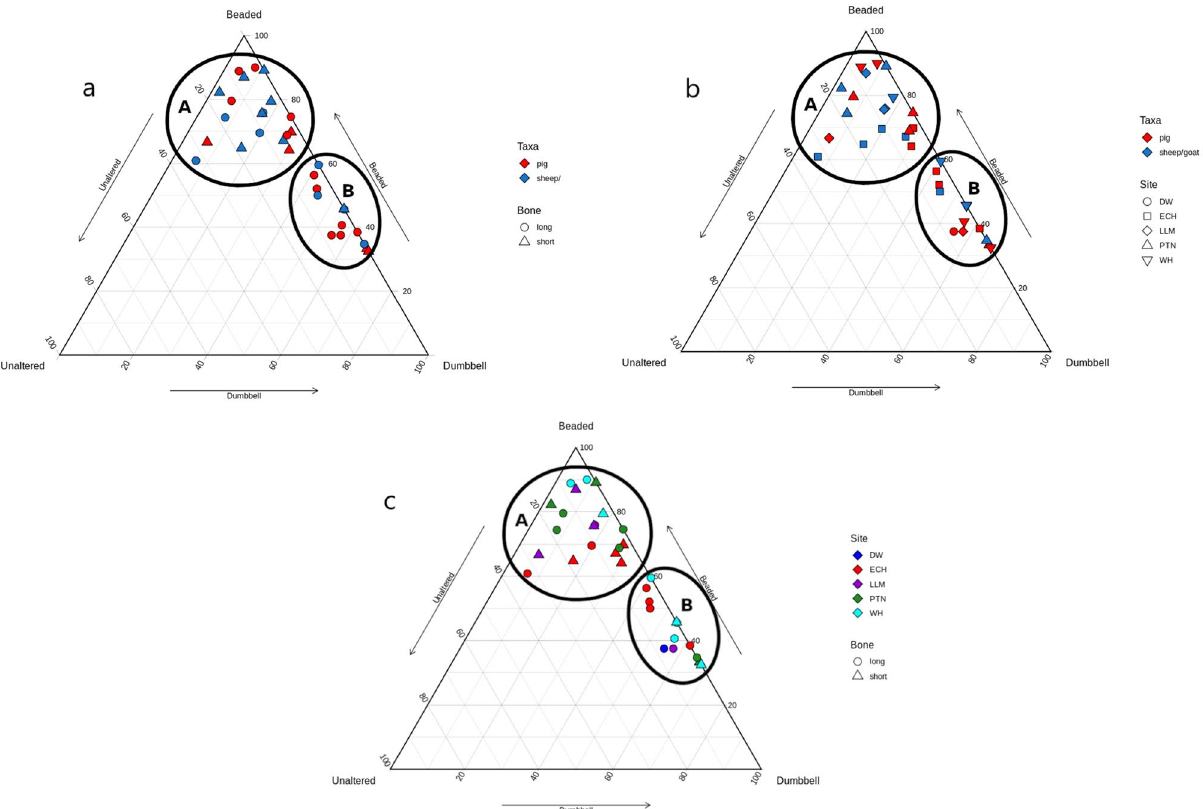
Figure 8. Ternary plot of all analysed samples. ( a ) presents the samples by element and species, ( b ) presents the samples by species and site, and ( c ) presents the samples by element and site. Cluster A represents Unheated samples and cluster B represents Heated samples. Categorisation is consistent with that of Koon 17 .